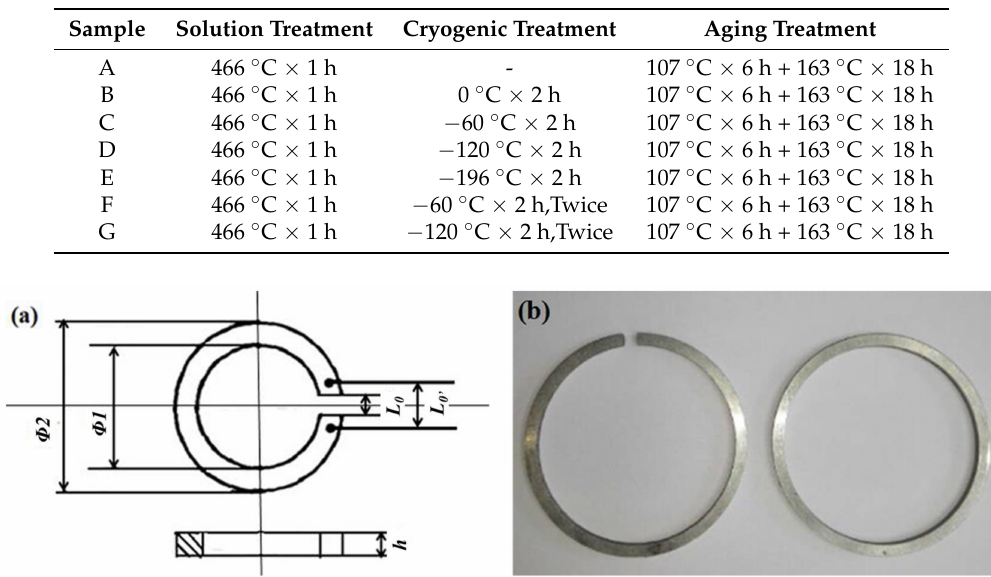
Table 2. Heat treatment process of 7075 aluminum alloy.